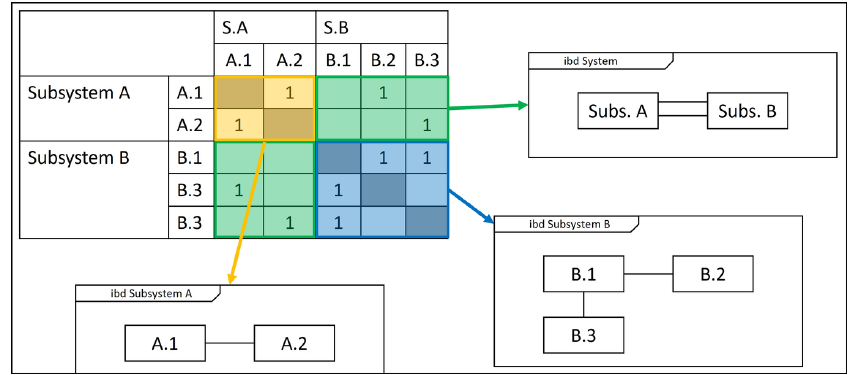
Figure 2. SysML model creation